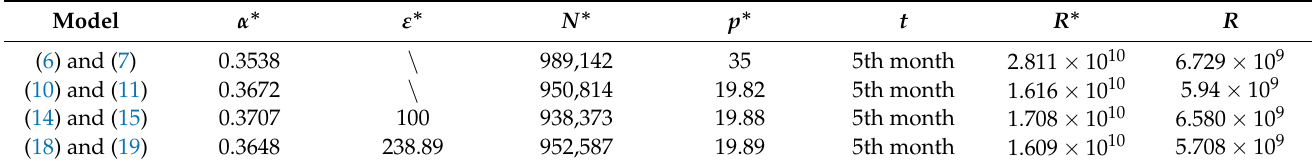
Table 2. Optimal breeding results based on the first group of parameter values. t is the start time of selling. Since N ( 0 ) < N ∗ , the optimal strategy is to sell when the livestock scale grows near N ∗ . R ∗ is the optimal profit obtained from 0 to terminal time T = 40. R is the profit obtained from 0 to terminal time T = 40 under no control. ε = 100 is determined by the productivity of the farm itself rather than by optimal control.